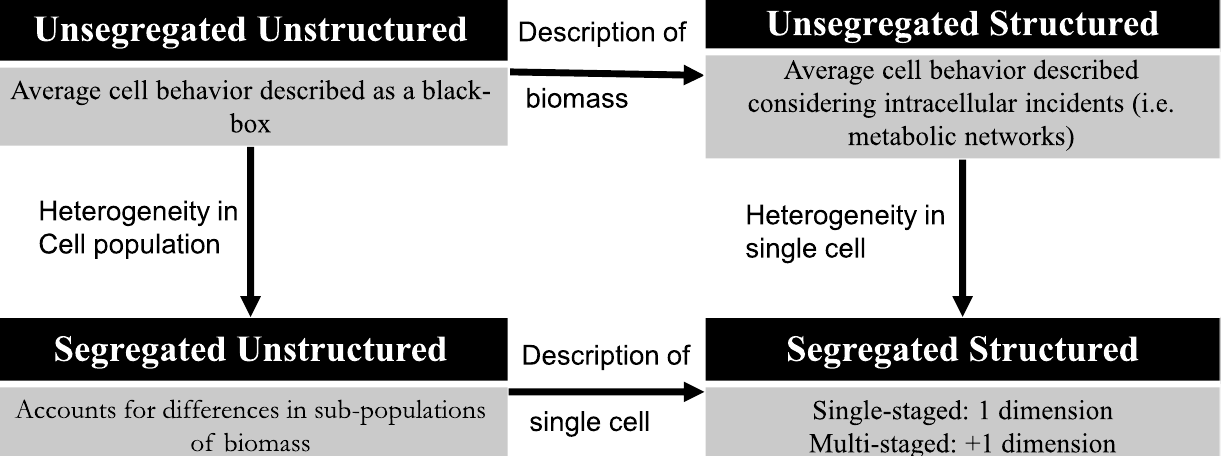
Figure 1. A broad classification of the mathematical metabolic models. The difference in the models that are shown originates from an average cell approximation and a balanced growth approximation in regard with (1) cell population, (2) a single cell. Reproduced with permission from [17].